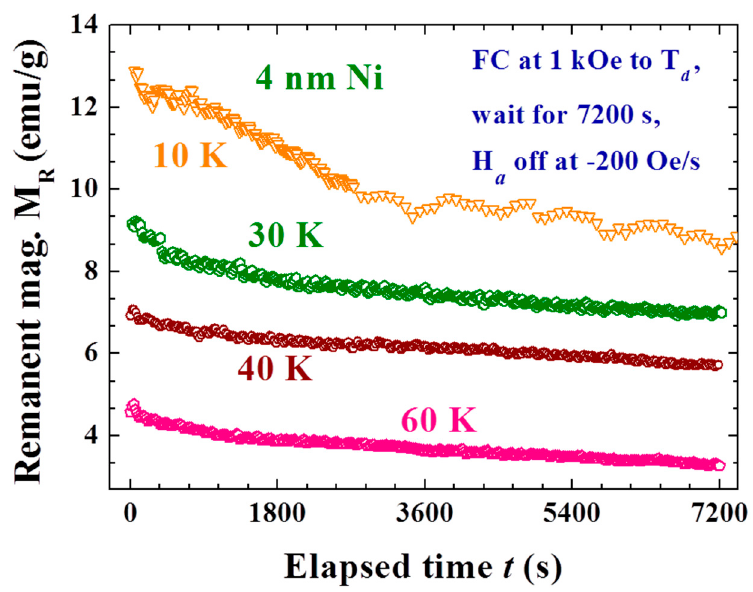
Figure 6. Time evolution of the remanent magnetization of the 4 nm Ni NP assembly recorded after field-cooling at H a = 1 kOe from 300 K to various T d , followed by a wait for 7200 s before turning off the H a at a rate of − 200 Oe/s.